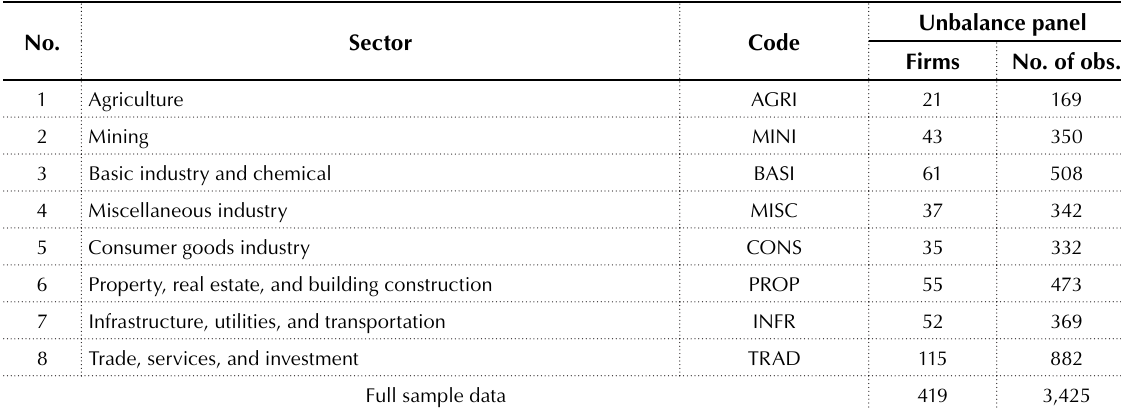
Table 2. Number of sample firms and number of observations